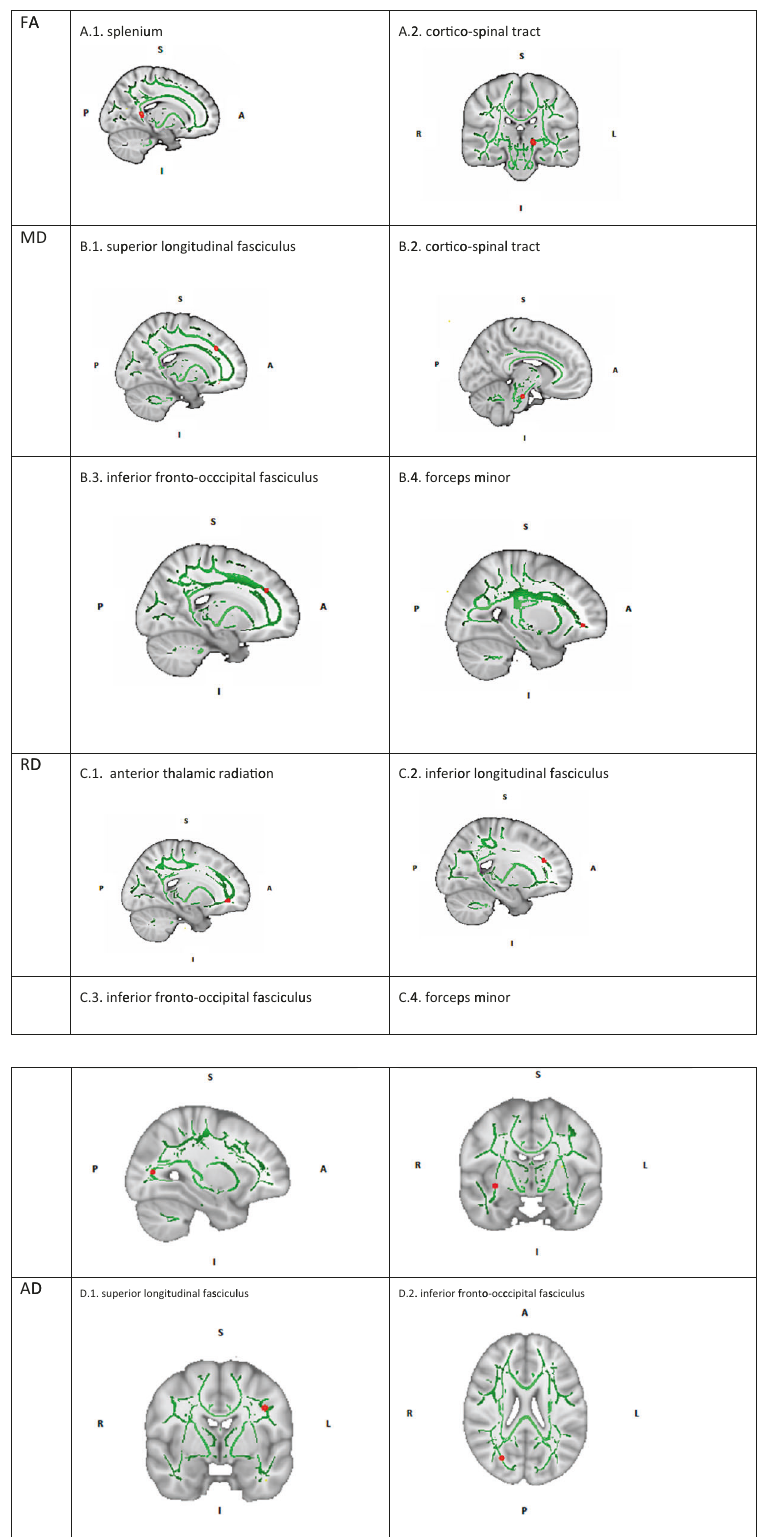
clinical characteristics, and ECT treatment information are presented in Table 1. ECT had a signi fi cant effect on depressive symptoms, as is demonstrated by the signi fi cant drop in HDRS-17 scores ( p < 0.0001, t = − 9.52). The response rate to ECT was